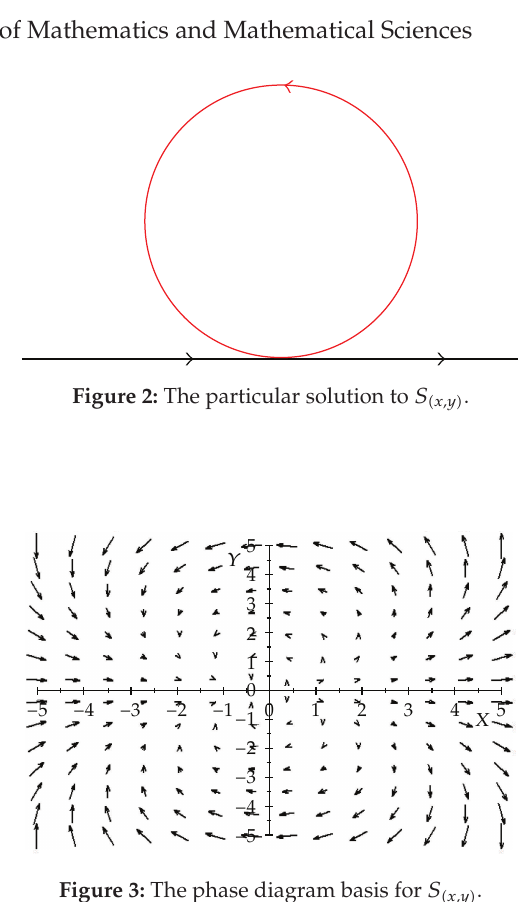
Figure 3: The phase diagram basis for S (cid:2) x,y (cid:3)